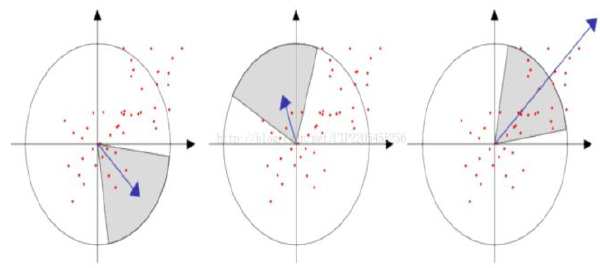
Figure 1. Interest Point Descriptor